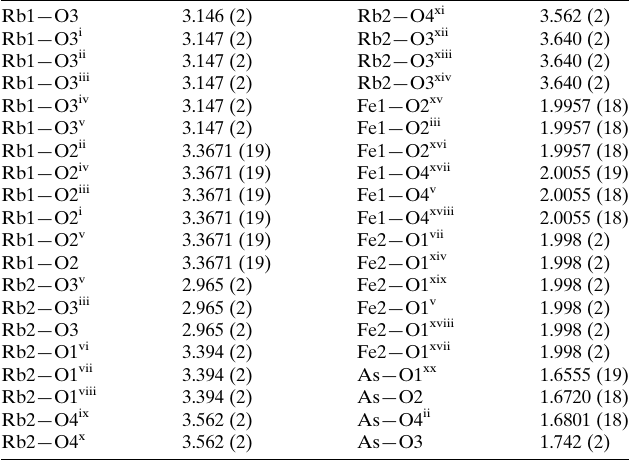
Table 4 Selected bond lengths (A˚ ) for RbFe(HAsO 4 ) 2 .